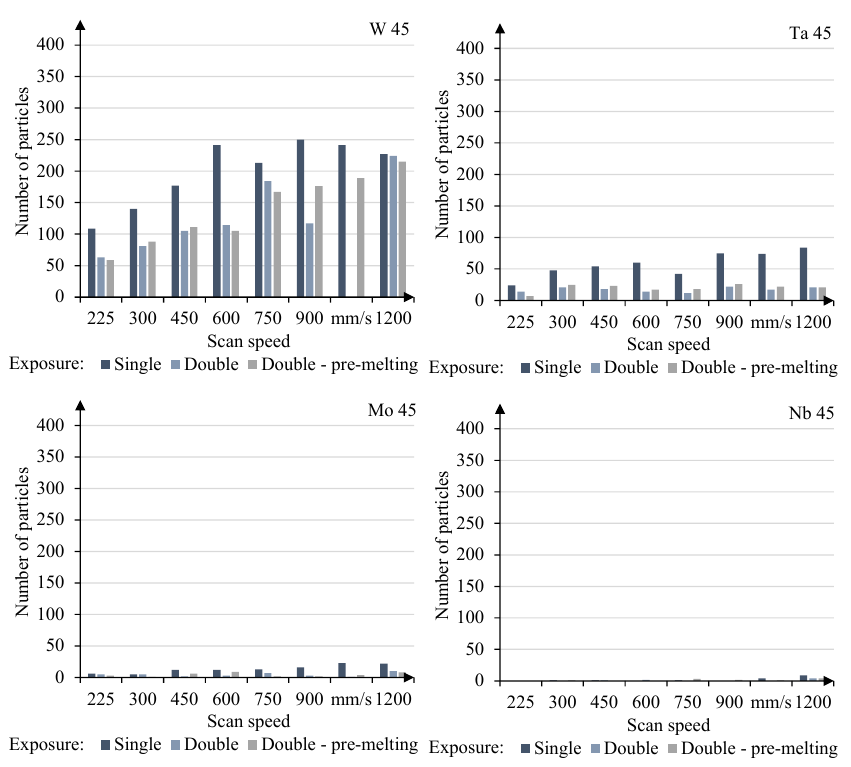
Figure A3. Results of experiments series 3 (also see Table 2); measurement area 3.8 mm 2 .